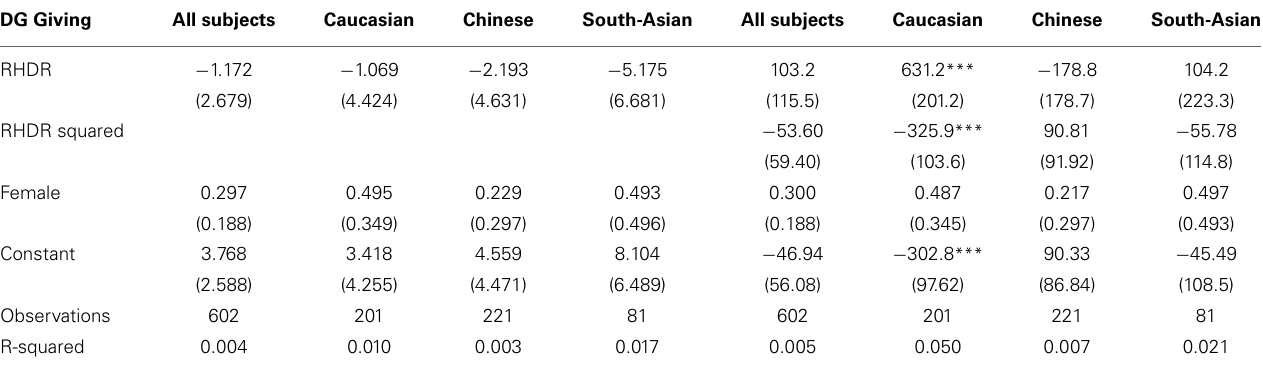
Table 4 | DG Giving and RHDR